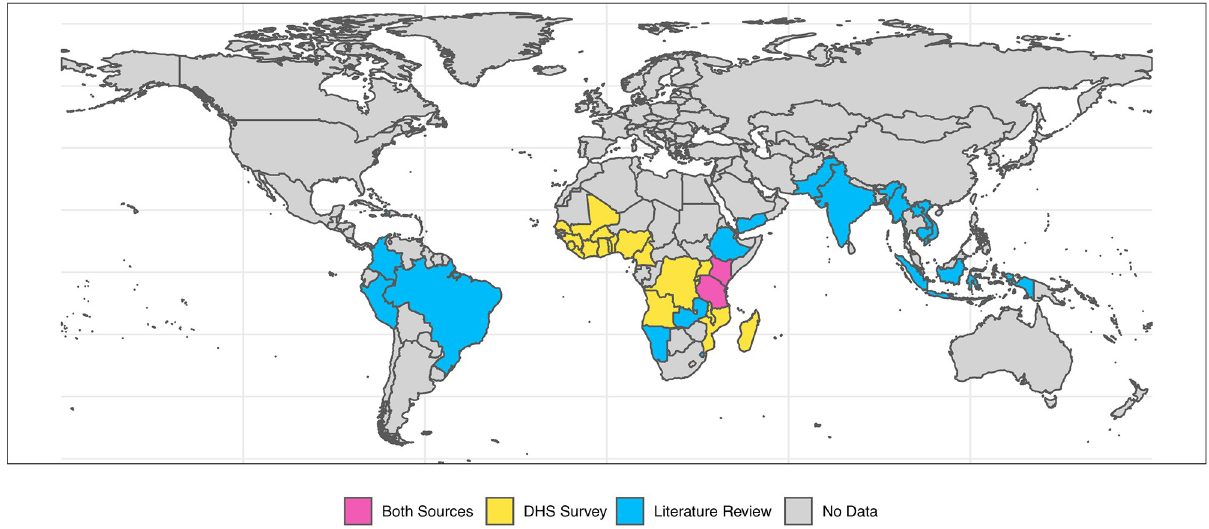
Fig 1. Global map highlighting the geographic distribution of countries where the data used in the statistical analysis of the DHS data and the meta-analysis were collected. The map of the world is shown with country boundaries demarcated by black lines. Countries where DHS data were available are shown in yellow ( n = 23), all in the African region. Countries across the American, African, Middle Eastern, and Asian regrions in blue contributed at least 1 study included in the meta-analysis ( n = 20). Two countries shown in pink were represented in both analyses. The world map was obtained from the rnaturalearch R package (version 0.1). DHS, demographic health survey.